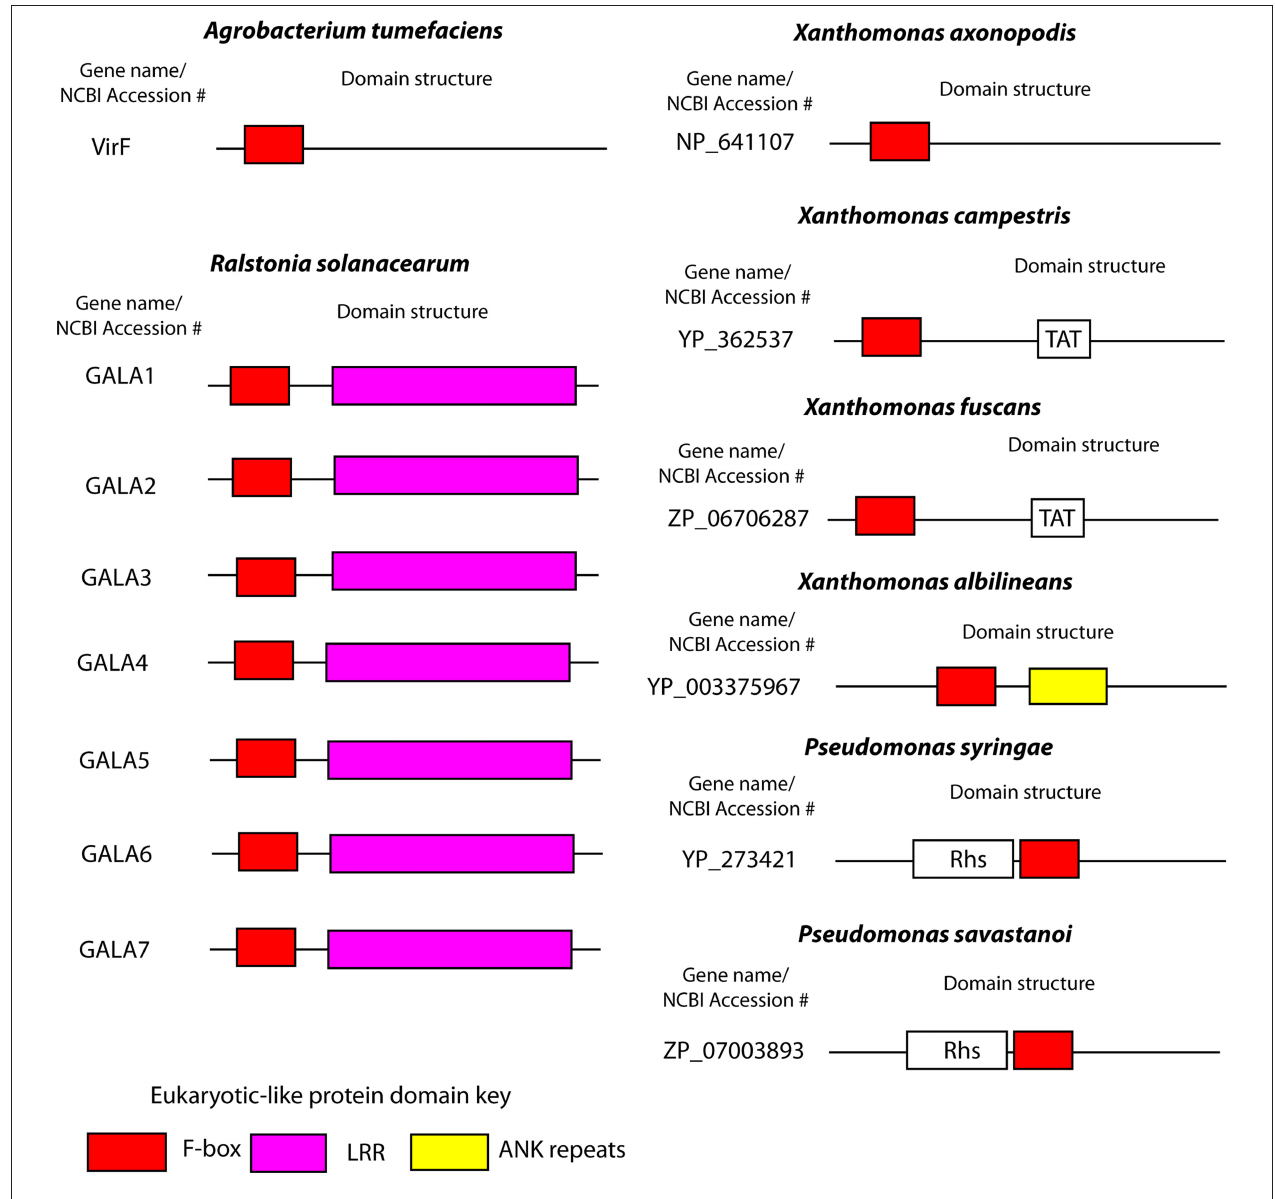
FiGure 3 | F-box proteins in plant pathogens. Cartoon representations of the domain structures of bacterial F-box proteins found in plant pathogens. Proteins and domain predictions were found at the EMBL-EBI website InterPro website (http://www.ebi.ac.uk/interpro), using the F-box domain motif IPR001810. Genes are identified by their name or NCBI accession